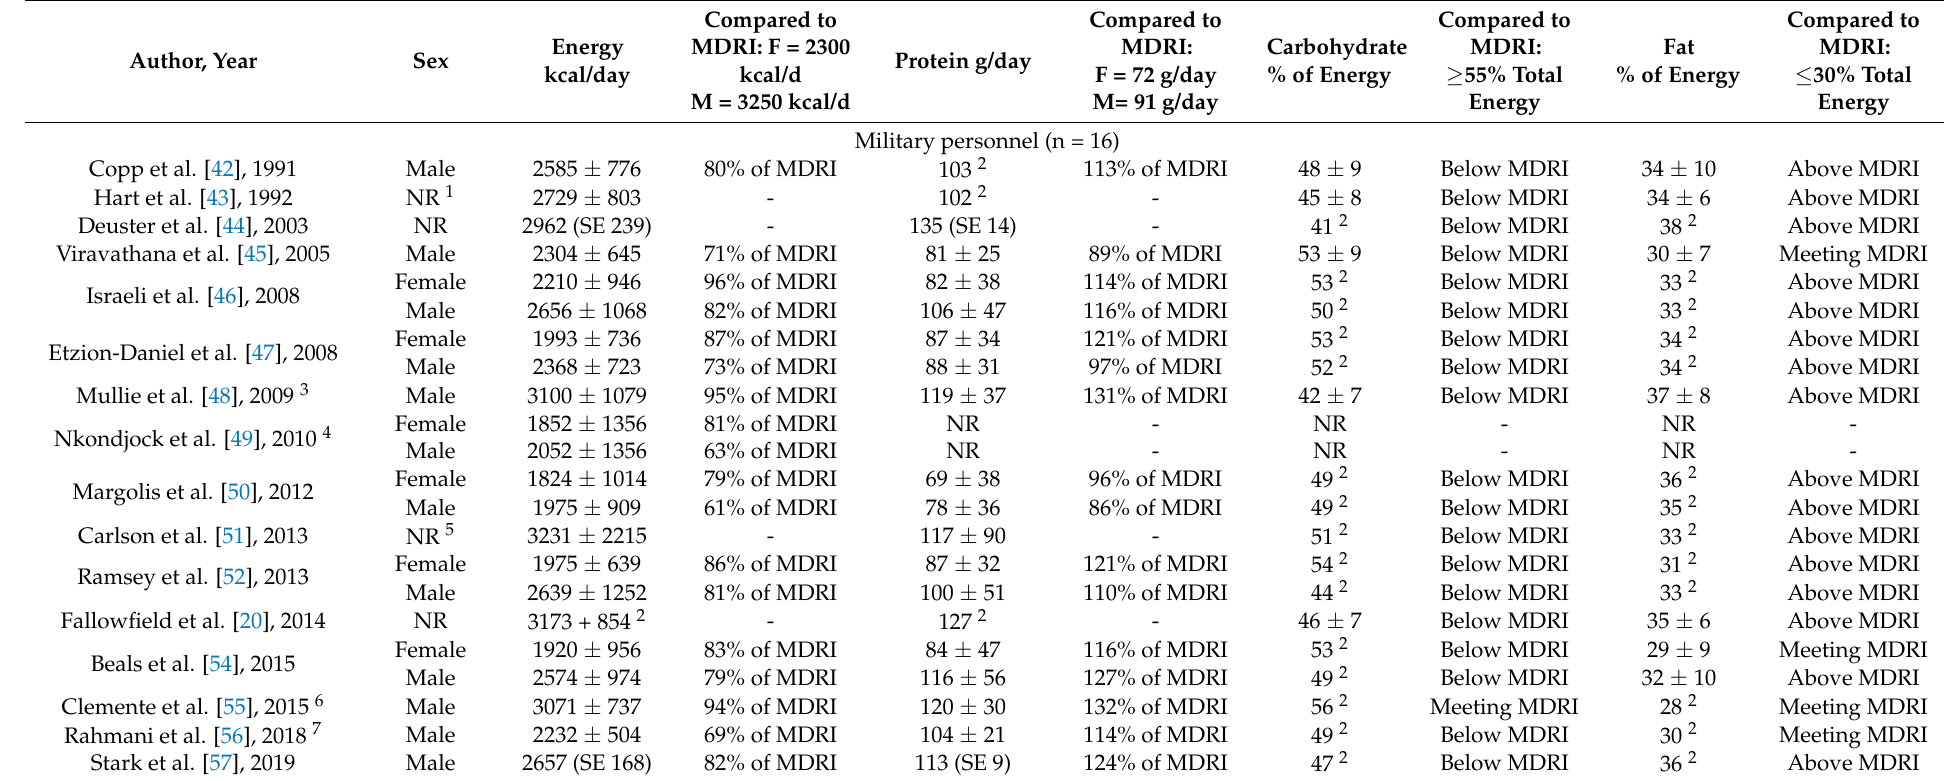
Table 3. Reported energy and macronutrient intakes of female and male tactical personnel in the included studies (N =